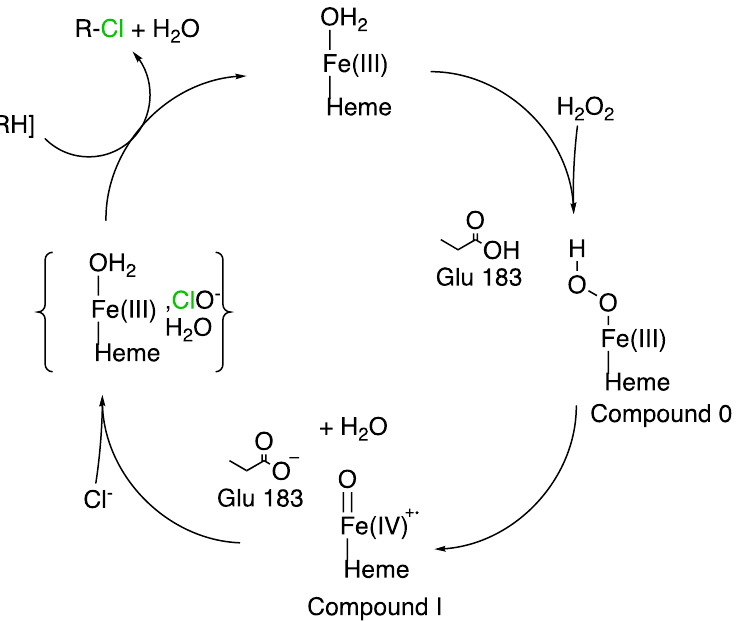
Figure 5. Schematic mechanism of hHPOs inspired by [75].